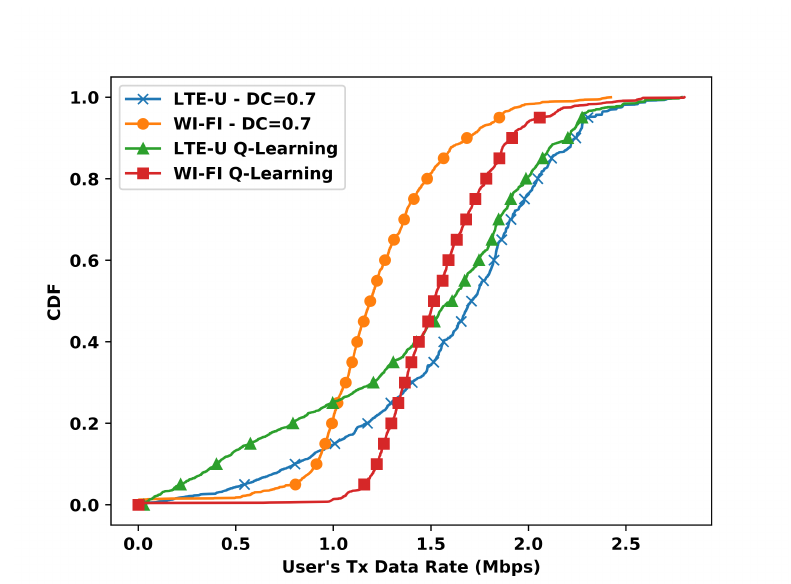
Figure 10. CDF of transmitted data rate per user vs Q-Learning for DC = 0.7.